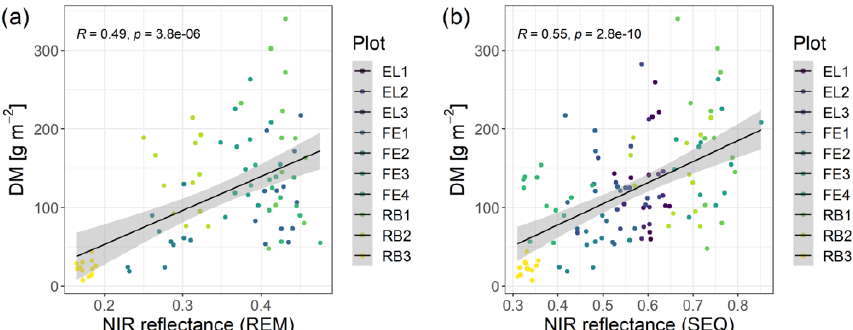
Figure 5. Scatterplots of NIR reflectance vs. DM with linear model fit (Spearman correlation coefficient and p value indicated in the plot) (a) for REM sensor and (b) for SEQ sensor. Note: there are fewer data points for REM, as there were no flights with this sensor at the Eschenlohe site.